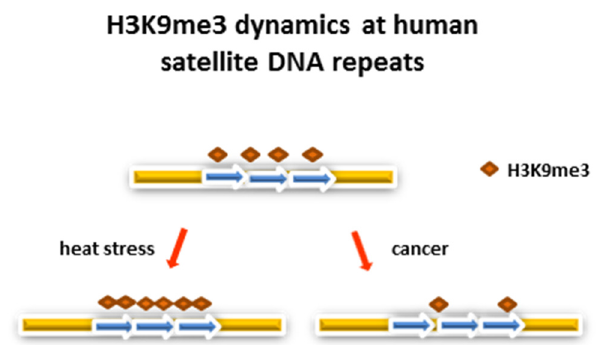
Figure 2. Dynamics of H3K9me3 level in human satellite DNA repeats. Enrichment of H3K9me3 at standard physiological conditions characterizes human satellite repeats located in both heterochro- matin and euchromatin. Additionally, H3K9me3 level in satellite DNA repeats is enriched upon heat stress (HS), while in cancer cells the H3K9me3 level is decreased relative to normal cells. Blue arrows indicate satellite DNA monomers.